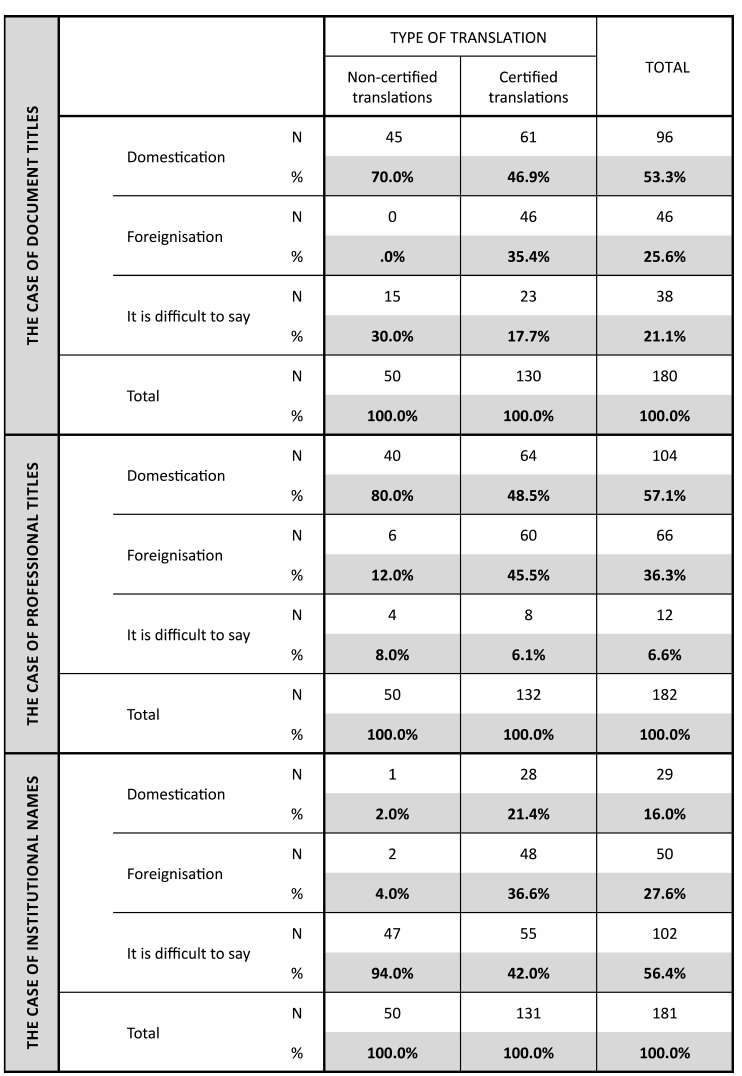
Cross tabulation between strategy and type of